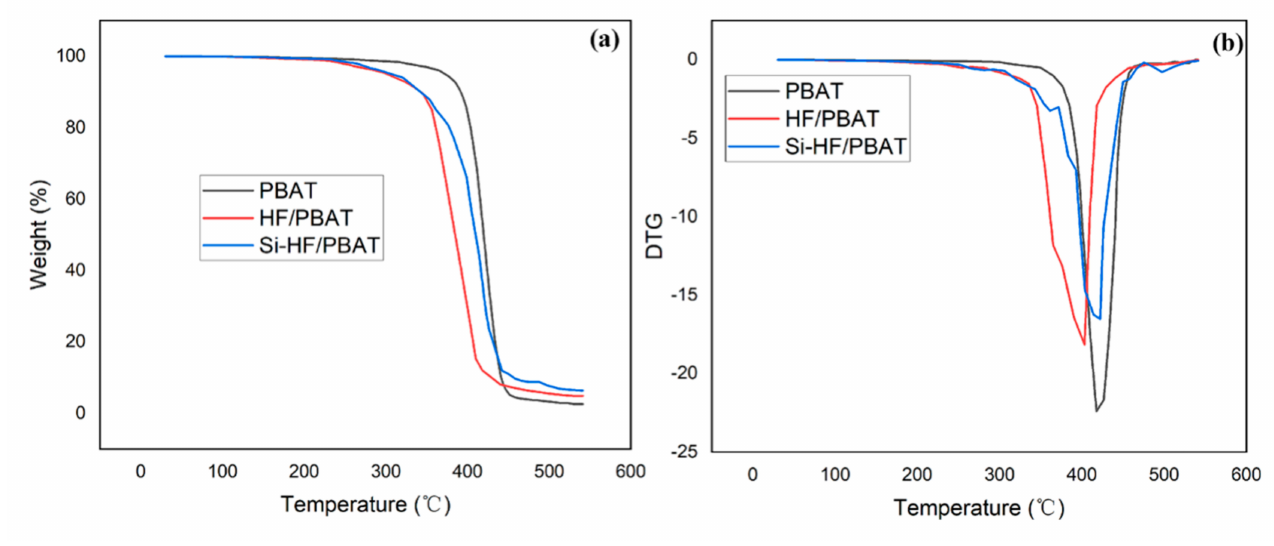
Figure 5. TGA ( a ) and DTG ( b ) curves for composite material. Heating rate of 10 ◦ C/min under argon (flow rate of 100 cm 3